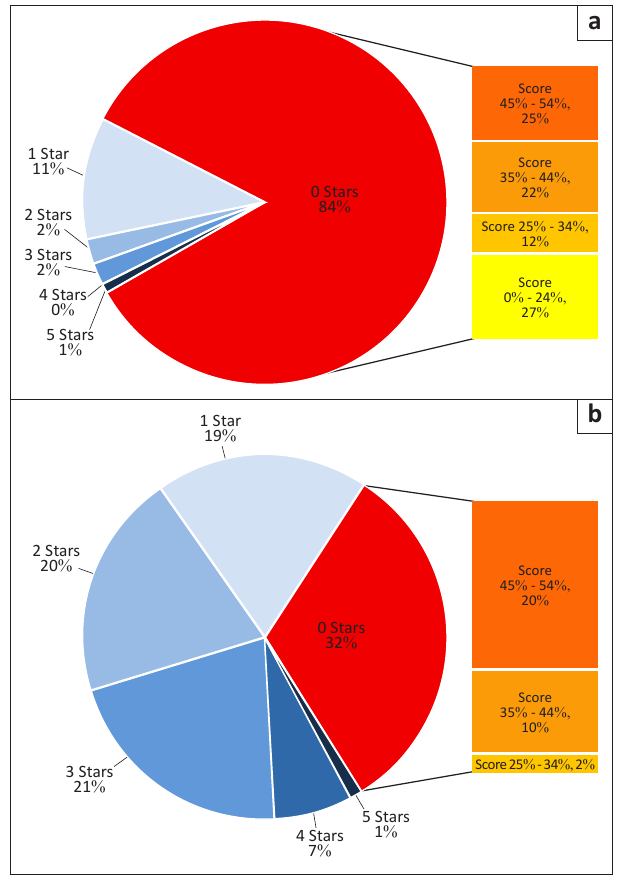
FIGURE 5: Estimated proportion of 43.5 million tests performed by star level of laboratories before (a) and after (b) SLMTA implementation, based on the Stepwise Laboratory Quality Improvement Process Towards Accreditation checklist scores for the 302 laboratories that completed the SLMTA programme. Before SLMTA: 16 % of tests were done in laboratories with at least one star. After SLMTA 68 % of tests were done in laboratories with at least one